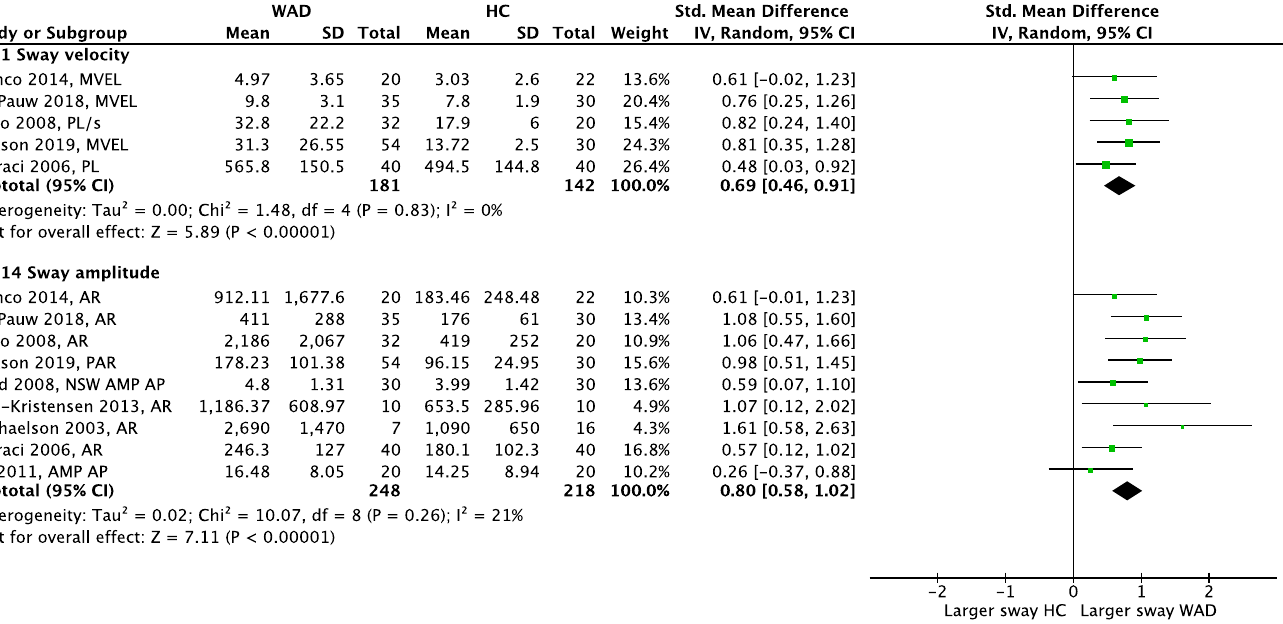
Fig 7. Forest plot demonstrating meta-analysis of sway velocity and sway amplitude (eyes closed) in people with WAD vs. HC. WAD: whiplash-associated disorder; HC: healthy control; SD: standard deviation; IV: inverse variance; CI: confidence interval; Std: standardized; MVEL: mean velocity (mm/s); PL: path length (mm); AR: area (mm 2 ); PAR: perimeter of sway area (mm); AMP: amplitude (mm); AP: anteroposterior; NSW: narrow stance width.